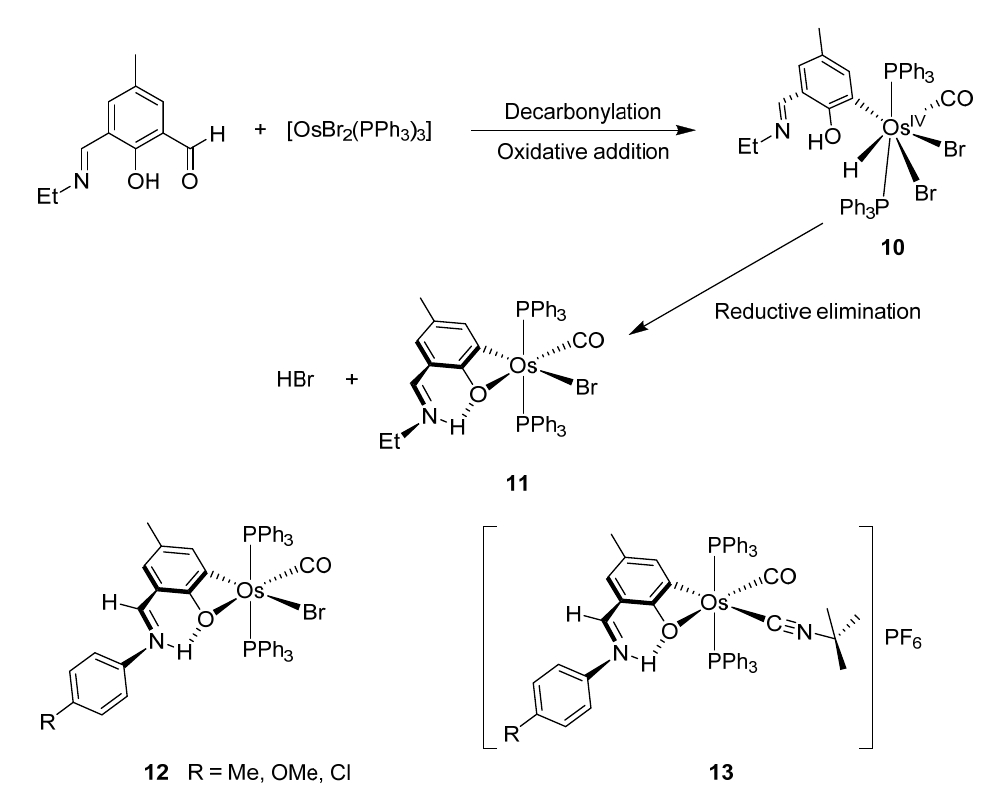
Figure 3. Synthesis of C~O cyclometalated complexes.